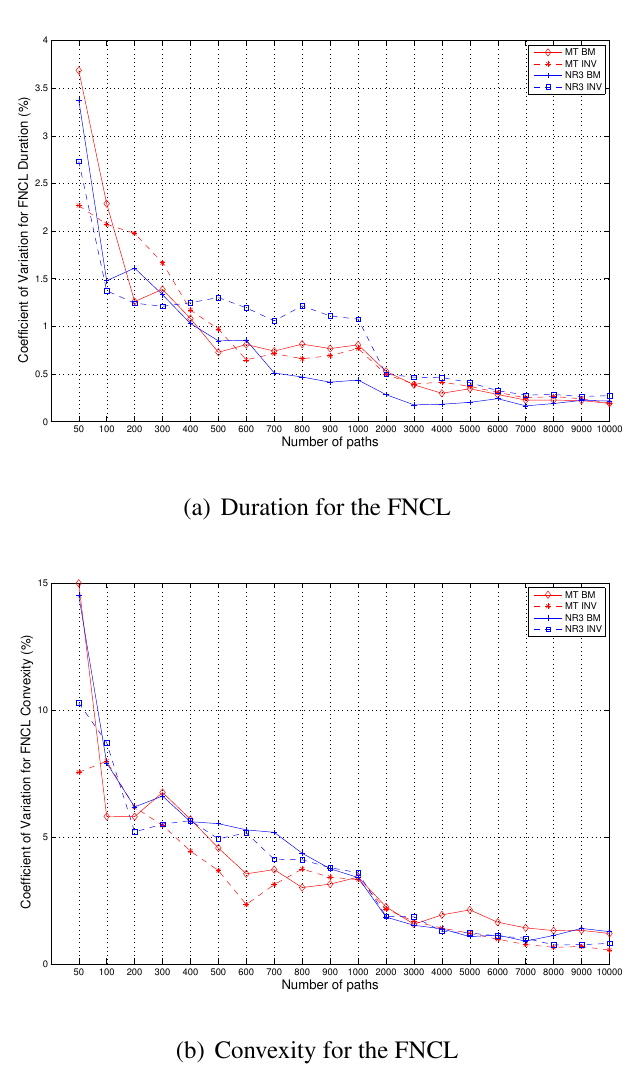
Figure 2. The Convergence of DUR and CNVX of the FNCL. The vertical axis is for the coefficient of variation (%). The horizontal axis is the number of